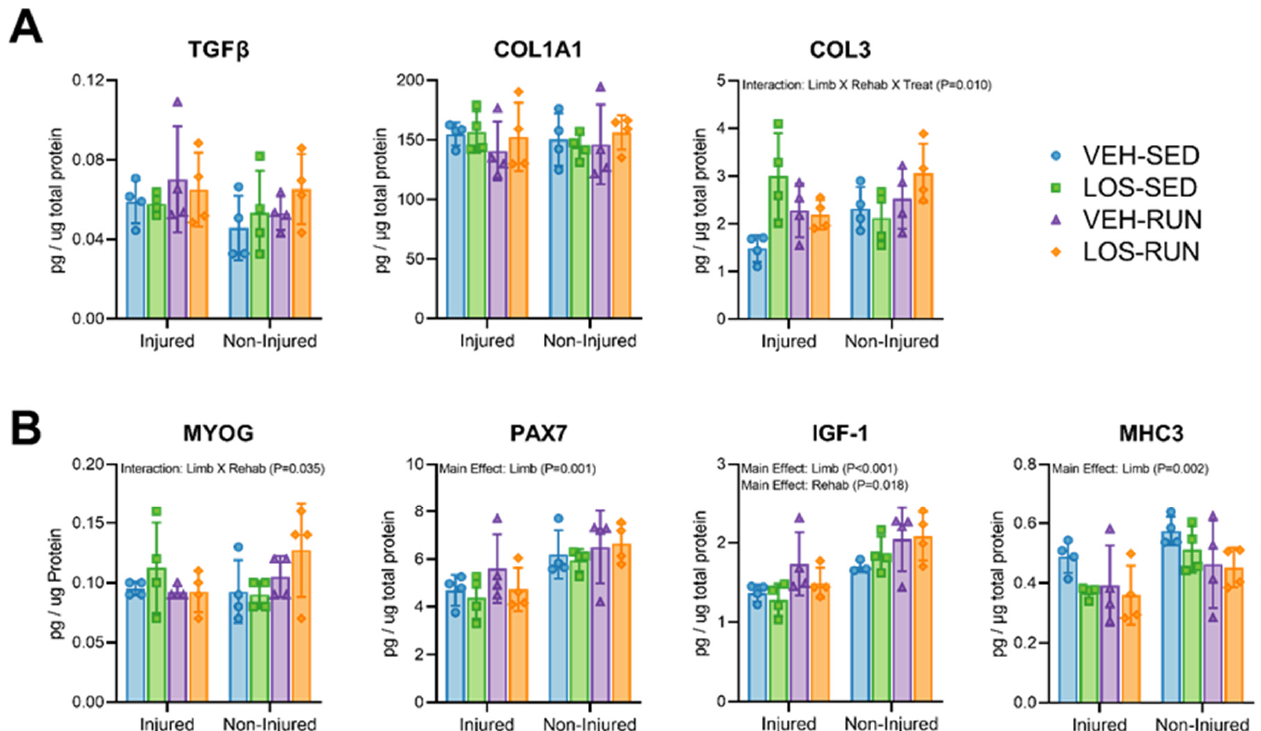
Figure 4. Pro-myogenic and pro-fibrotic protein quantification from injured and uninjured contralateral control limbs. Evaluation of pro-fibrotic ( A ) and pro-myogenic ( B ) protein presence in VML-injured and non-injured limbs was analyzed at the 56 DPI endpoint. No significant differences were observed for pro-fibrotic proteins, with the exception of an interaction for COL3. Pro-myogenic proteins displayed an overall increased trend in the non-injured limbs, and rehabilitation had a significant positive effect on IGF-1. Data are presented as mean ± SD; n = 3–4 rats per group. Differences were considered significant when p < 0.05 by fitting a Mixed-Effects model and the Holm–Sidak post hoc method.